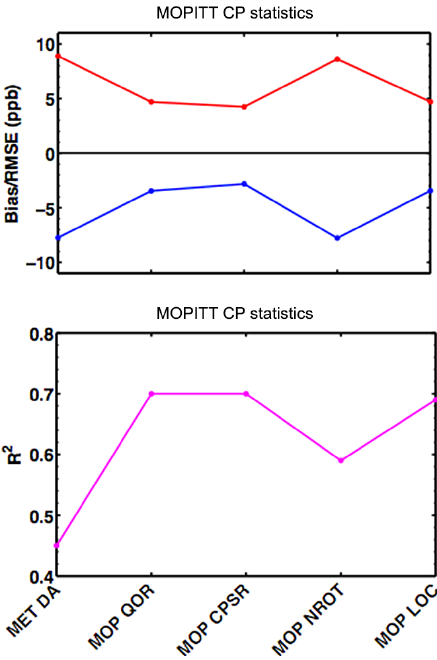
Figure 8. Verification statistics for all experiments in MOPITT re- trieval space. The blue curve is the bias (model – observation), the red curve is the root mean square error (RMSE), and the magenta curve is the coefficient of determination. The experiments are de- scribed in the text and summarized in Table